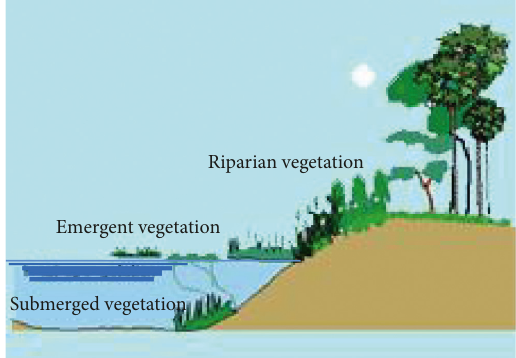
Figure 1: Example of riparian zone and